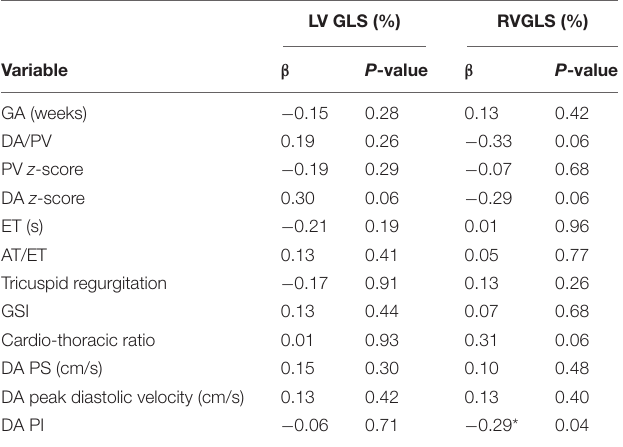
TABLE 6 | The univariate regression analysis for RVGLS and LVGLS in the premature DC group. LV GLS (%) RVGLS (%)